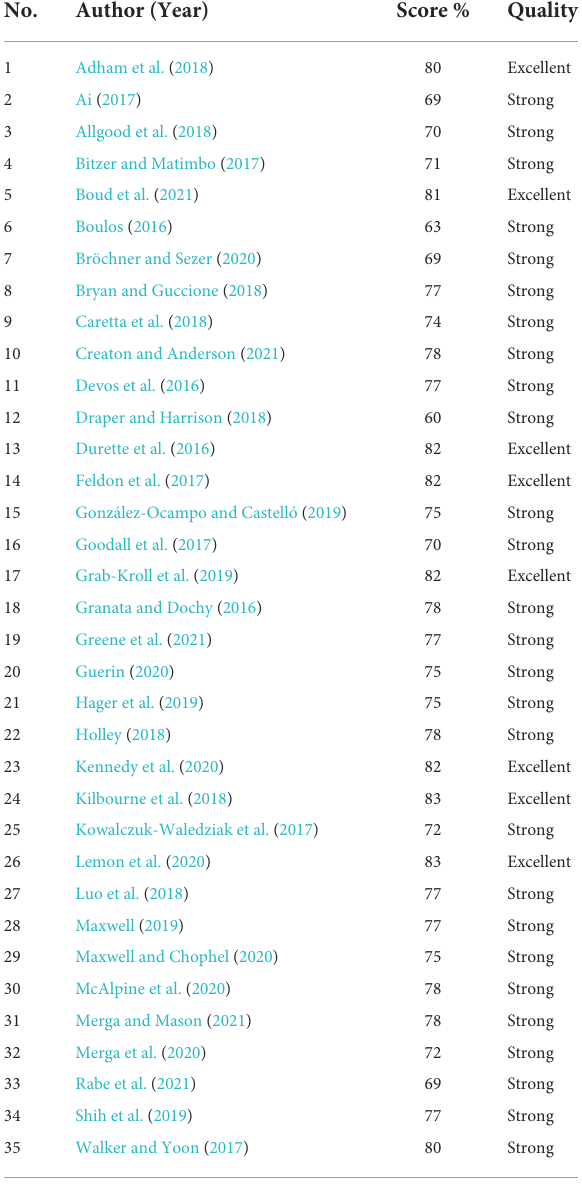
TABLE 2 Quality appraisal scores of included